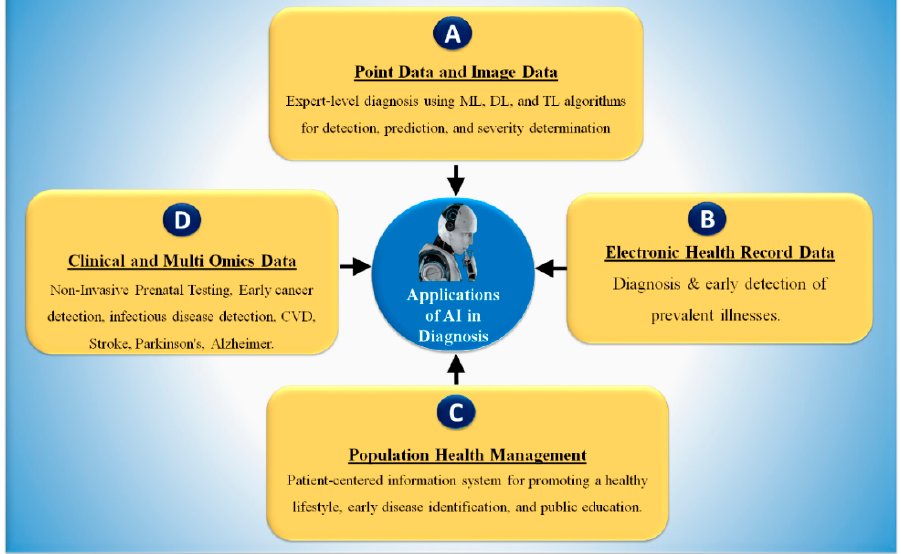
Figure 5. Applications of AI in healthcare diagnosis. AI: artificial intelligence, ML: machine learning, DL: deep learning, TL: transfer learning, CVD: cardiovascular diseases.